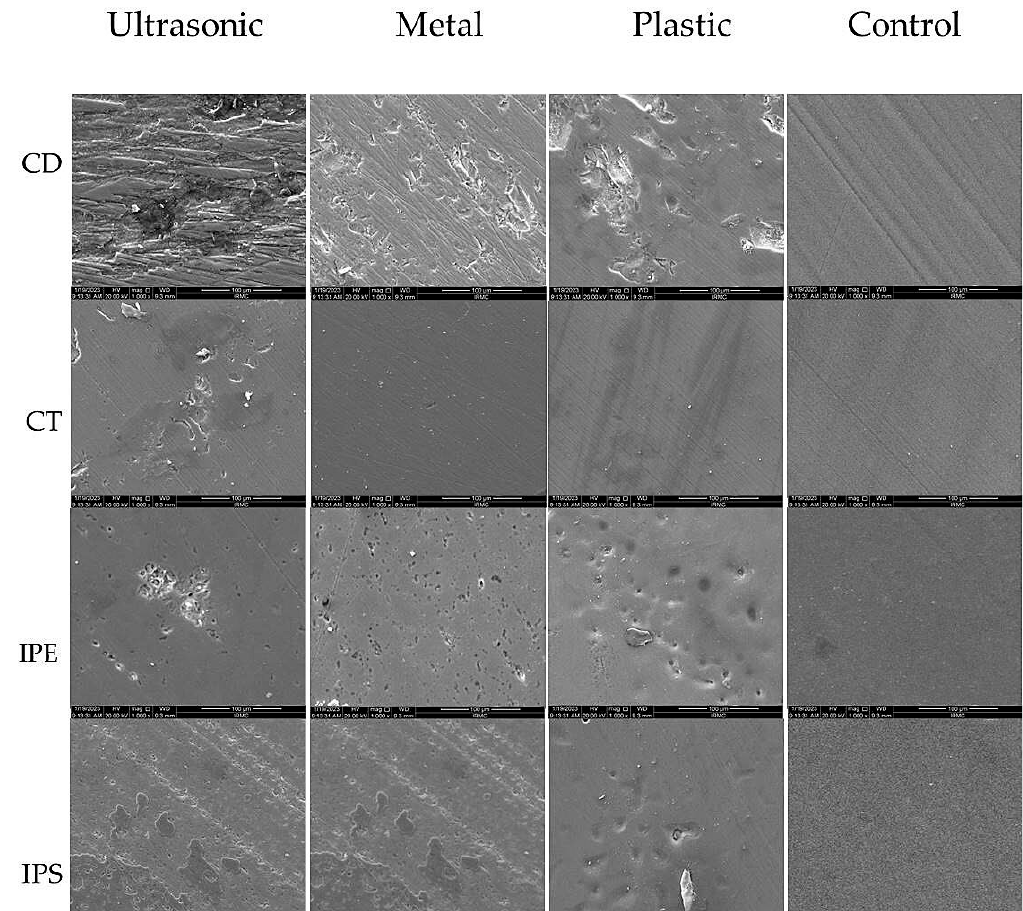
Figure 7. SEM images of the CAD/CAM ceramic materials (CD, CT, IPE, and IPS) treated with three treatment methods: ultrasound, manual metal, and plastic tips in addition to no scaling (control) in ×1000 magnification and scale bar 100 µm. CD; zirconia-reinforced lithium silicate (Celtra Duo). CT; advanced lithium disilicate (CEREC Tessera). IPE; lithium disilicate (IPS Emax CAD). IPS; leucite-reinforced (IPS Empress CAD).